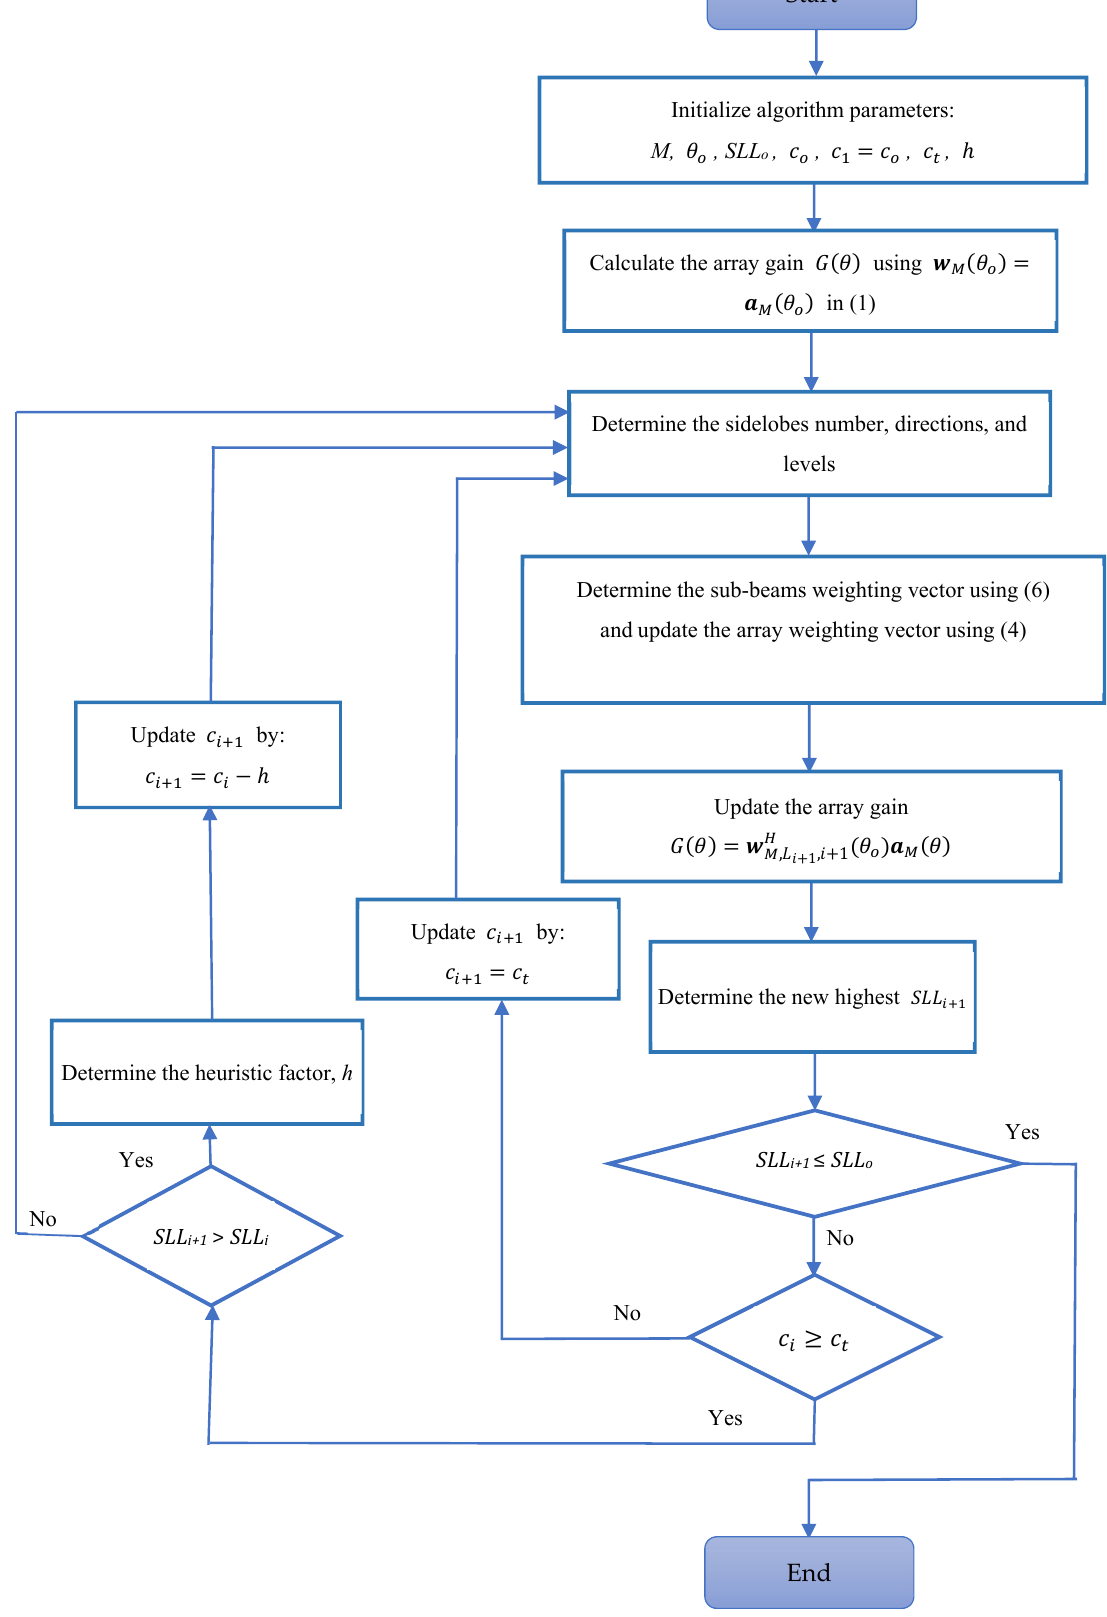
Figure 4. Flowchart of the adaptive SSR algorithm.